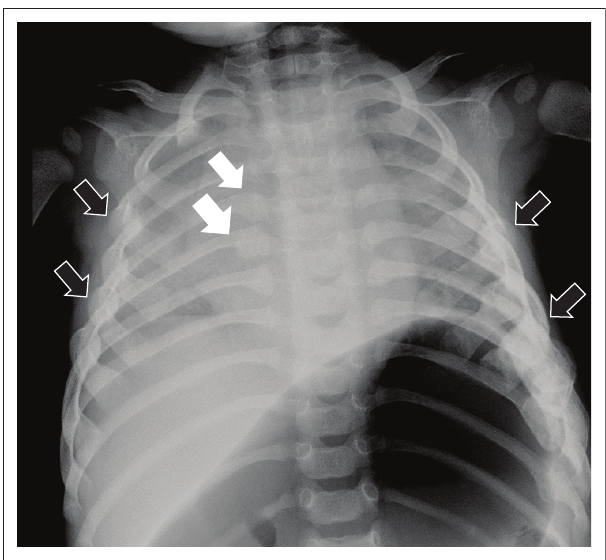
FIGURE 2: Three-year-old female with bilateral anterior (black arrows) and posterior healed rib fractures (white arrows) on an AP chest view. These are high-specificity fractures for NAI.